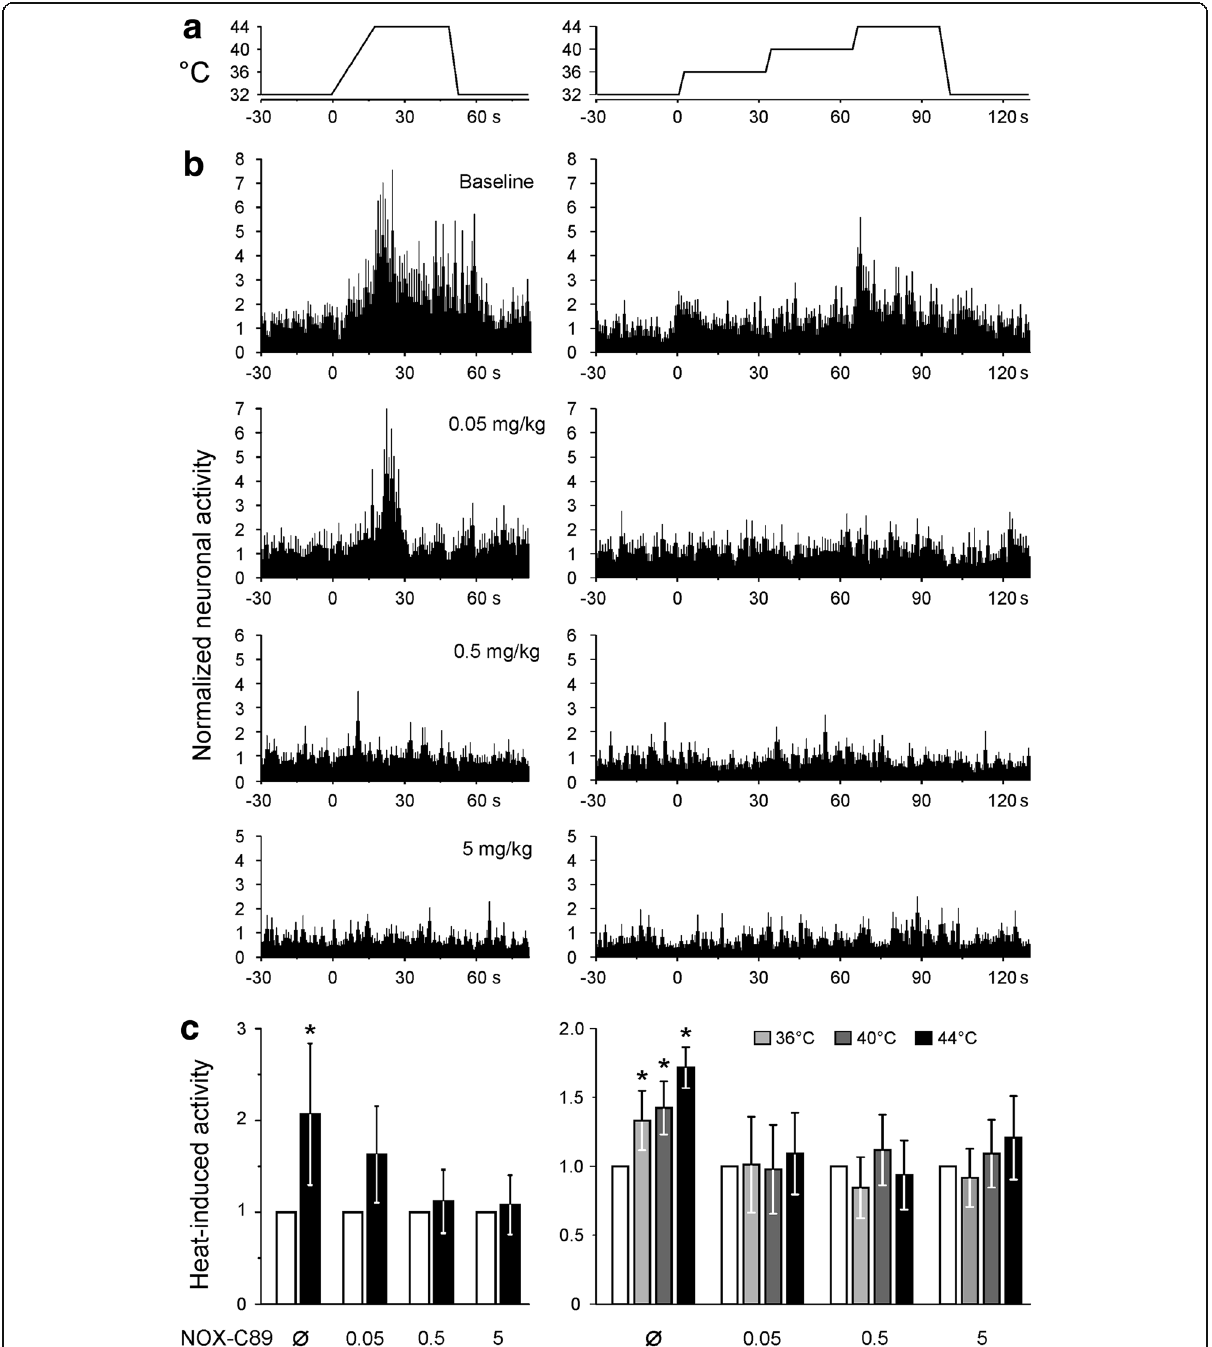
Fig. 2 Heat evoked activity of units with afferent input from the exposed cranial dura mater recorded in the spinal trigeminal nucleus caudalis. a Heat sensitivity was obtained at baseline and after all infusions as visualized and at the time points shown in Fig. 1. The temperature at the dura was first ramped from 32 to 44 °C and held for 30 s. In a second protocol, the temperature was rapidly stepped from 32 to 36, 40 and 44 °C. b The response of eight spinal trigeminal neurons at baseline and after incremental additions of NOX-C89 0.05 – 5 mg/kg (mean±sem) during the temperature protocols shown in panel A. c Average activity during the whole period of elevated temperature was increased above baseline. Similarly, all temperature steps in- creased neuronal activity. NOX-C89 infusion at all doses inhibited the neuronal response to thermal stimulation (*p <0.05). Data are